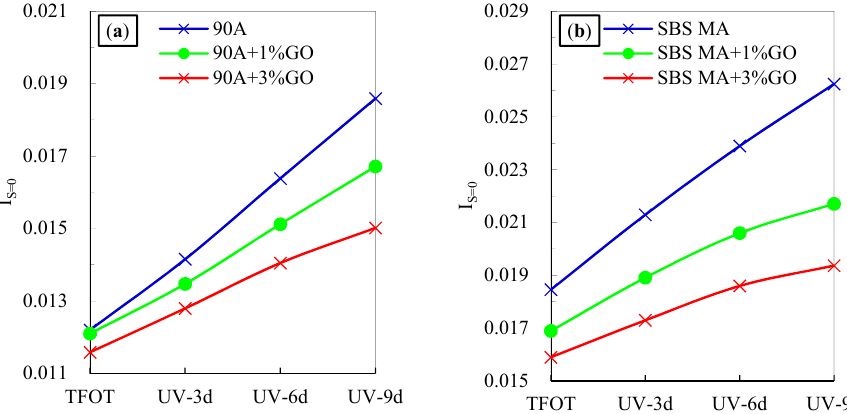
Figure 3. The I S=O of 90 A ( a ) and SBS MA ( b ) after UV aging.